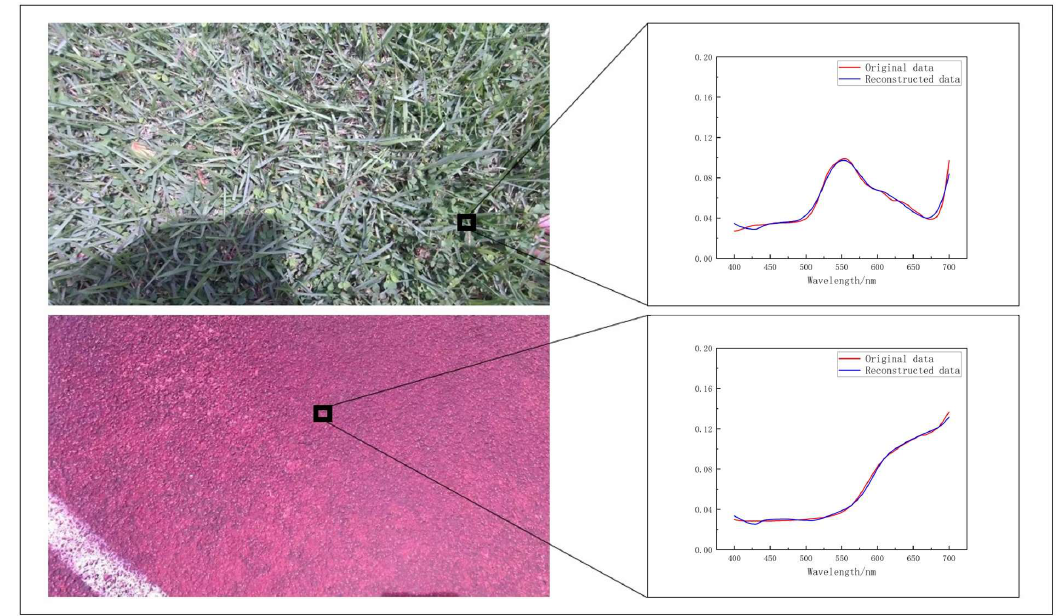
Figure 8. Reconstructed spectrum by WER-Net.